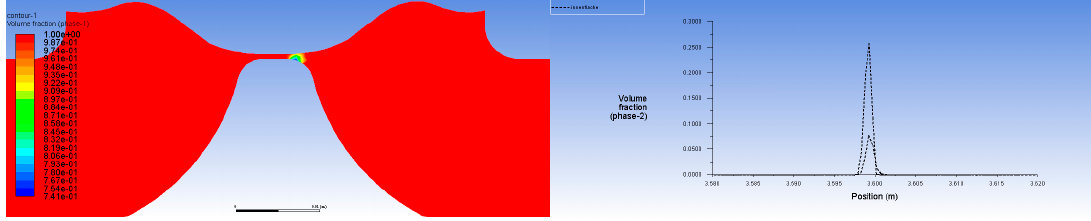
Figure 14. Volume fraction α of two phases and void fraction distribution of cavitation phase in valve flow field.